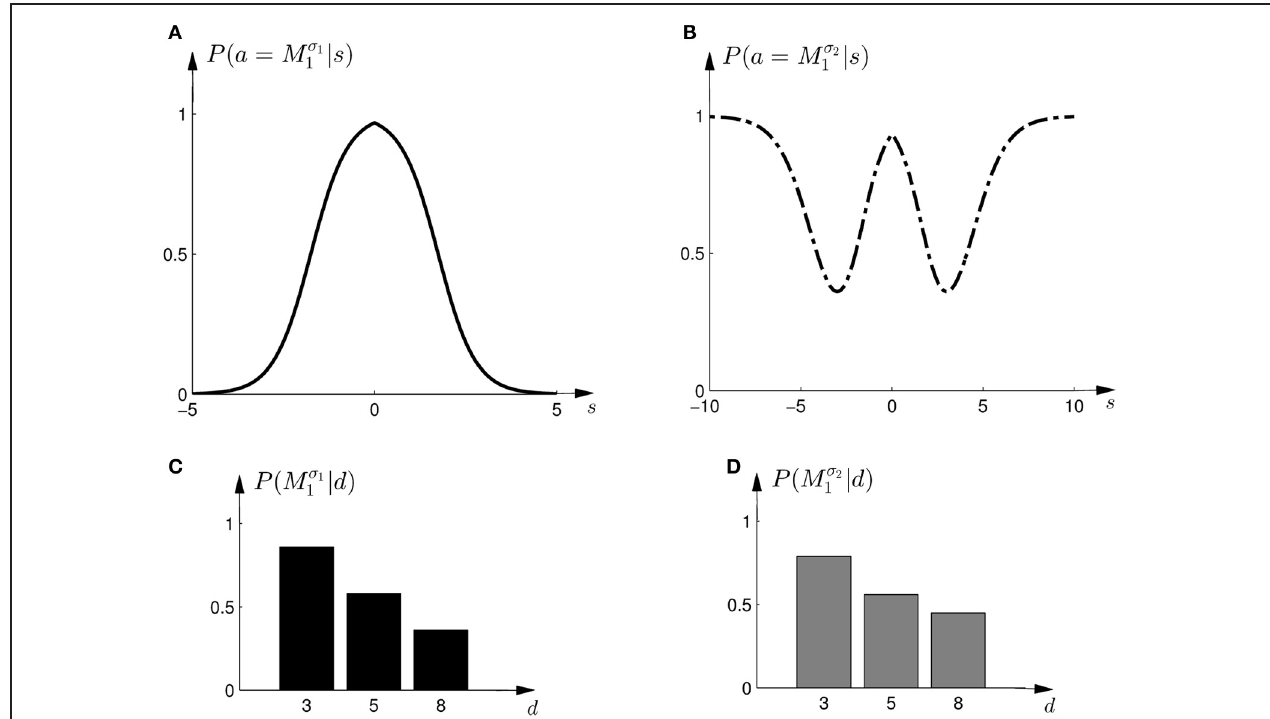
FIGURE 8 | Construction of predicted choice probabilities following Bayesian policy inference. (A) Shows the fitted choice probabilities of selecting model M 1 in standard trials when the shift s is known for a typical subject in the first part of the experiment. Model M 1 is mostly selected for small shifts. (B) Shows same as panel (A) but for the